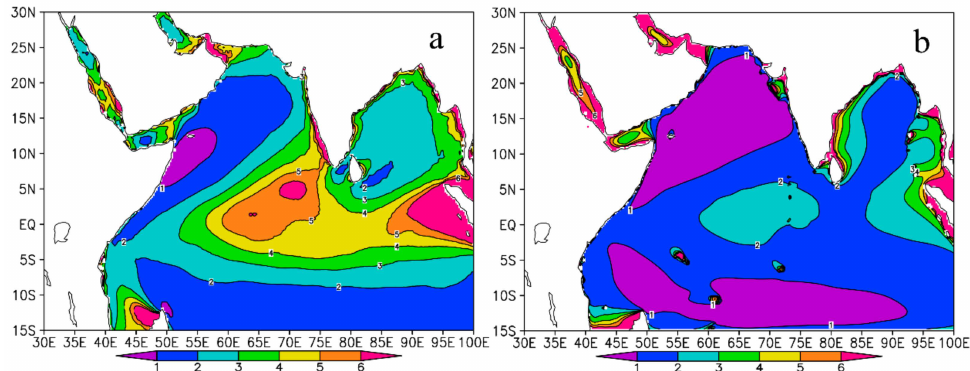
Figure 11. Monthly Variability Index of wind energy density ( a ) and wave energy density ( b